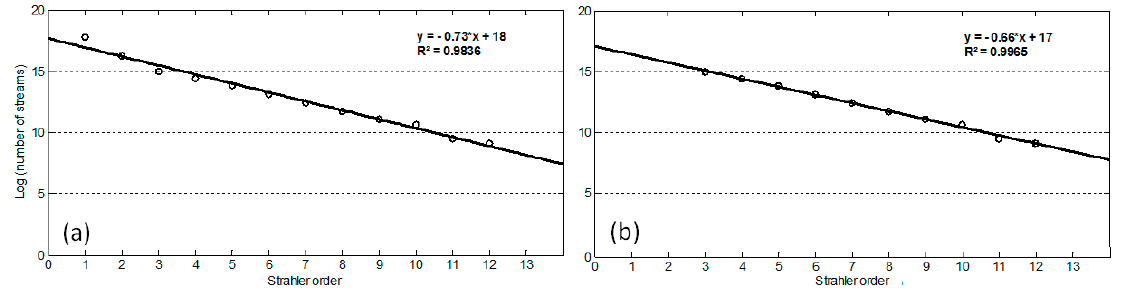
Figure 10. Fractal behaviour of the hydrographic network as illustrated by the variation of the logarithm of the number of streams for each Strahler order as a function of this order, for orders 1 to 12 ( a ) and 3 to 12 ( b ). Source: [108].